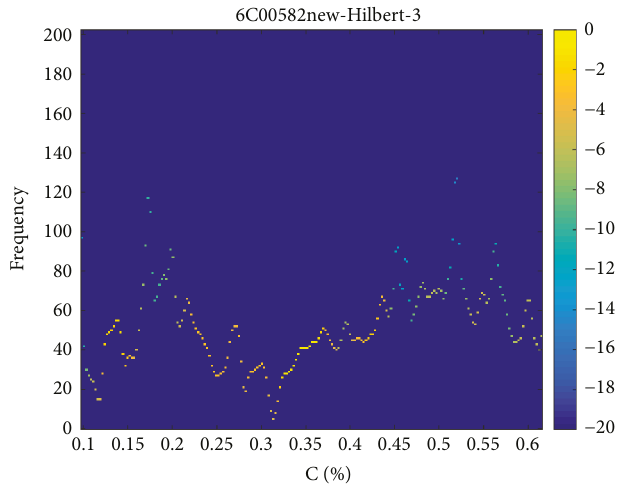
Figure 11: Hilbert spectrum diagram of IMF-3 signalled with absolute intensity.